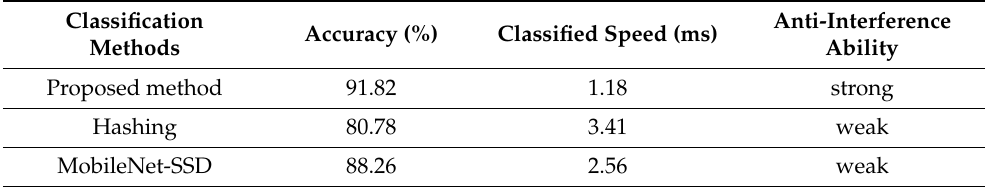
Table 1. Comparison of proposed and existing classification